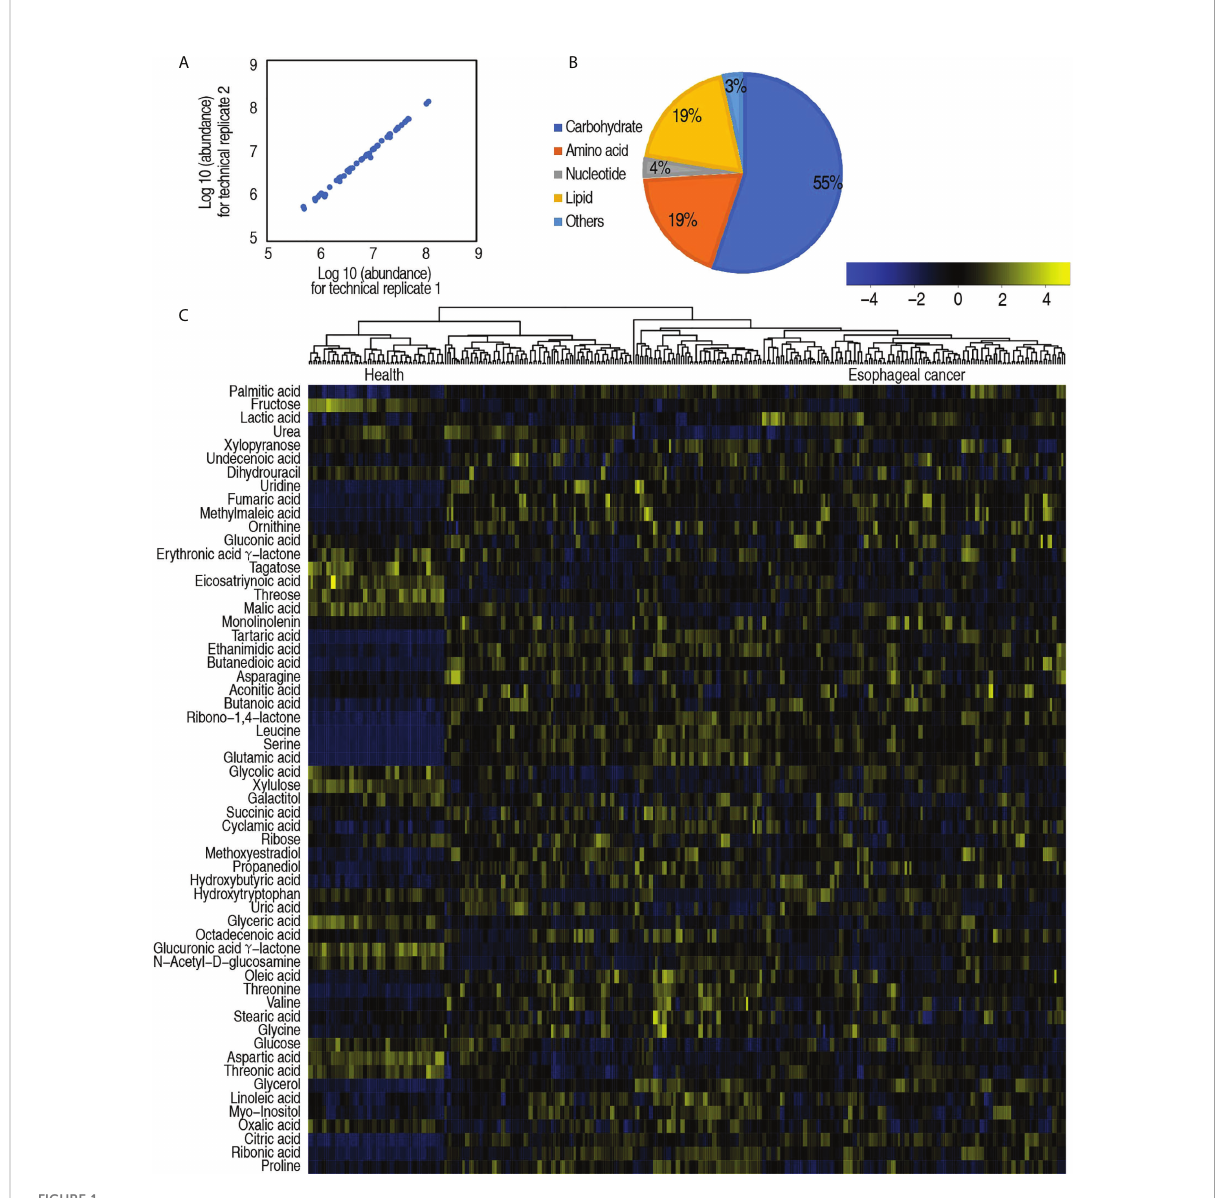
FIGURE 1 Serum metabolic pro fi le of patients with esophageal cancer. (A) Reproducibility of metabolomic pro fi ling platform. Abundance of metabolites quanti fi ed in samples over two technical repeats is shown. Correlation coef fi cient between technical repeats varies between 0.990 and 0.999. (B) Categories of the global metabolites. (C) Heatmap showing global metabolites. Yellow color and blue color indicate increase and decrease of metabolites relative to the median metabolite level, respectively (see color